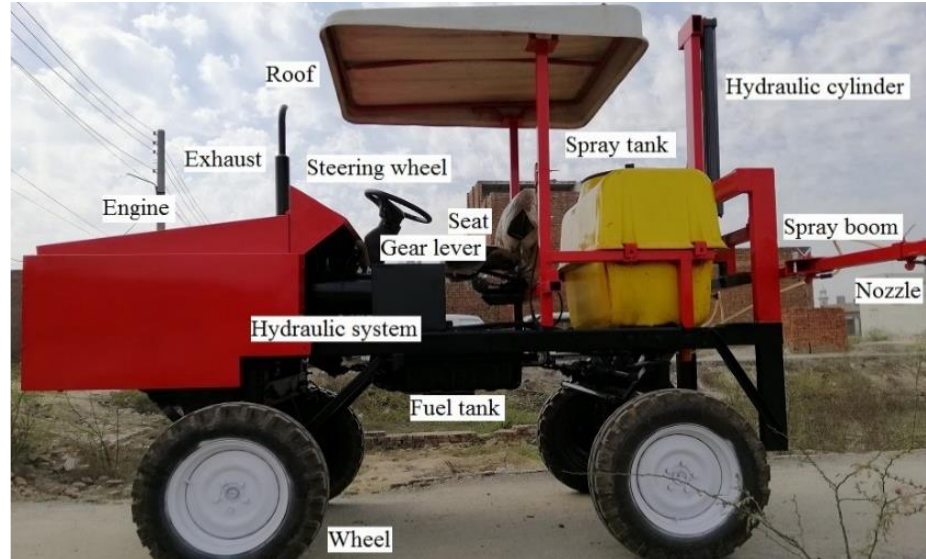
Figure 1. Self-propelled variable height crop sprayer.